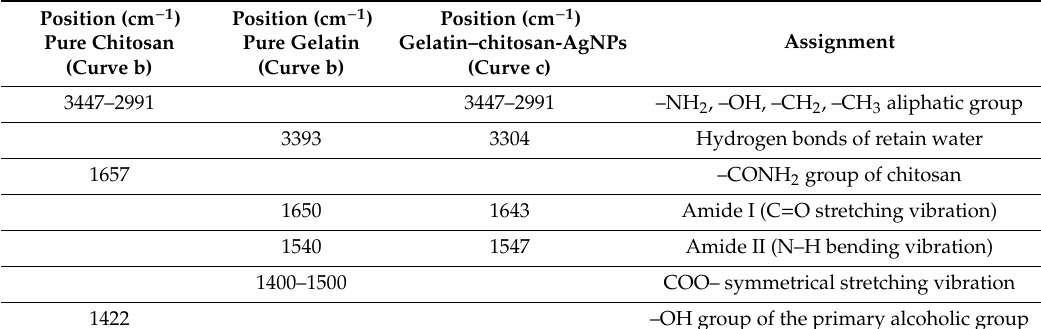
Table 3. FT-IR band positions of pure gelatin, pure chitosan, and gelatin–chitosan mixture-AgNPs presented in Figure